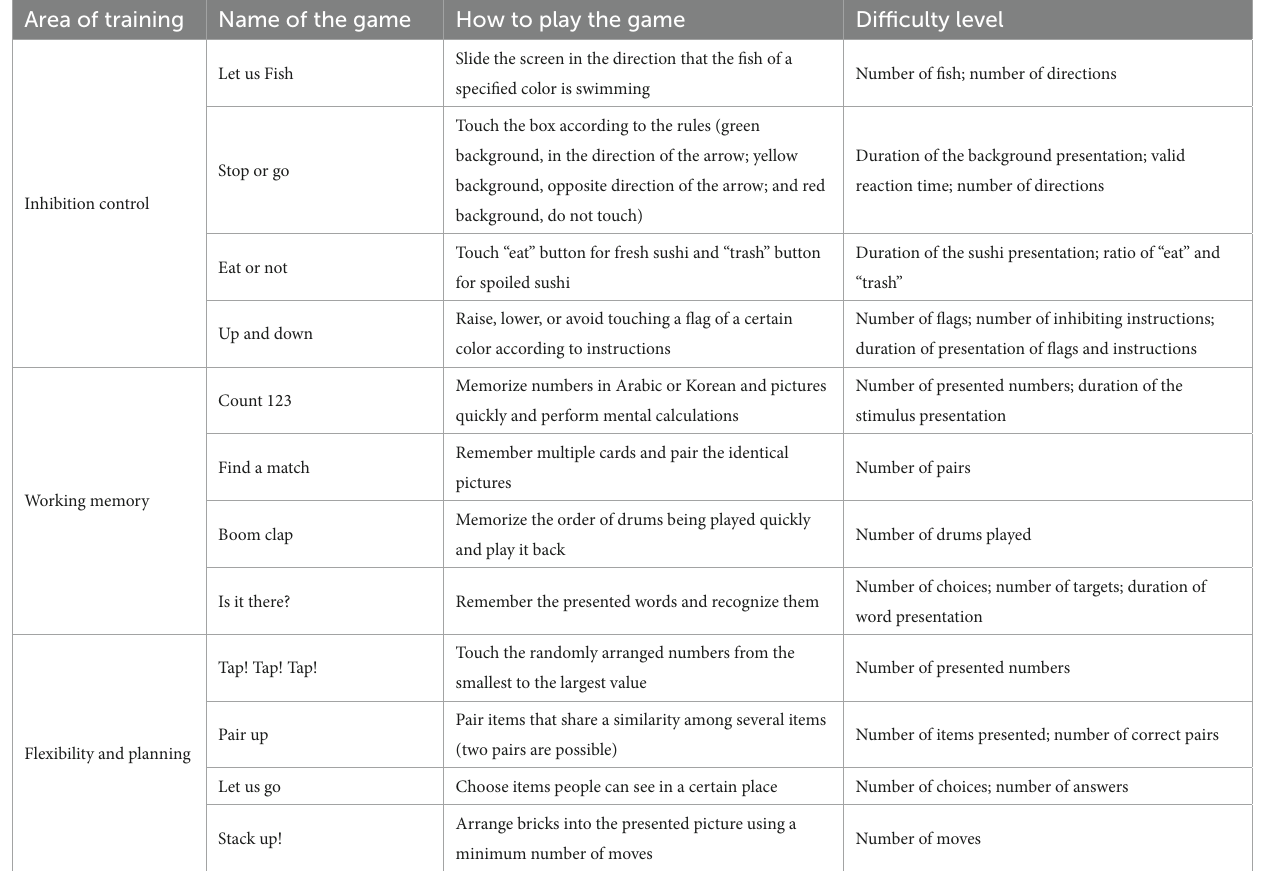
TABLE 3 Description of 12 games in the Ycog training